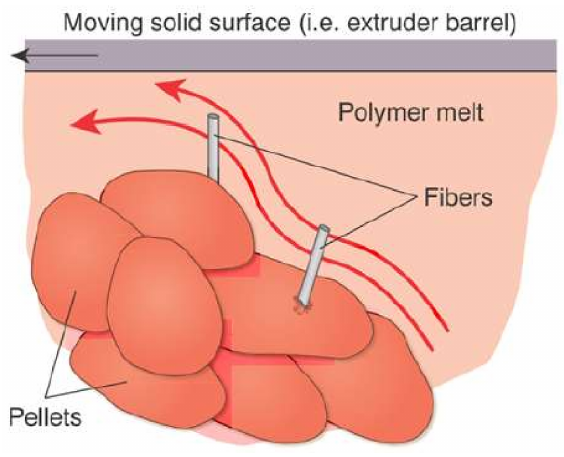
Figure 1. Fibre-matrix interaction, fibre damage mechanism at the interface between solid pellets and polymer melt